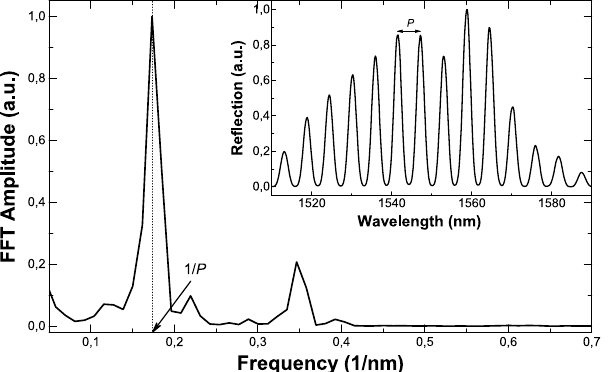
Figure 3. Amplitude of the FFT as a function of frequency of the interference pattern shown in the inset. The latter was observed in a device fabricated with L f = 30 cm of MCF. P is the period of the interference pattern.